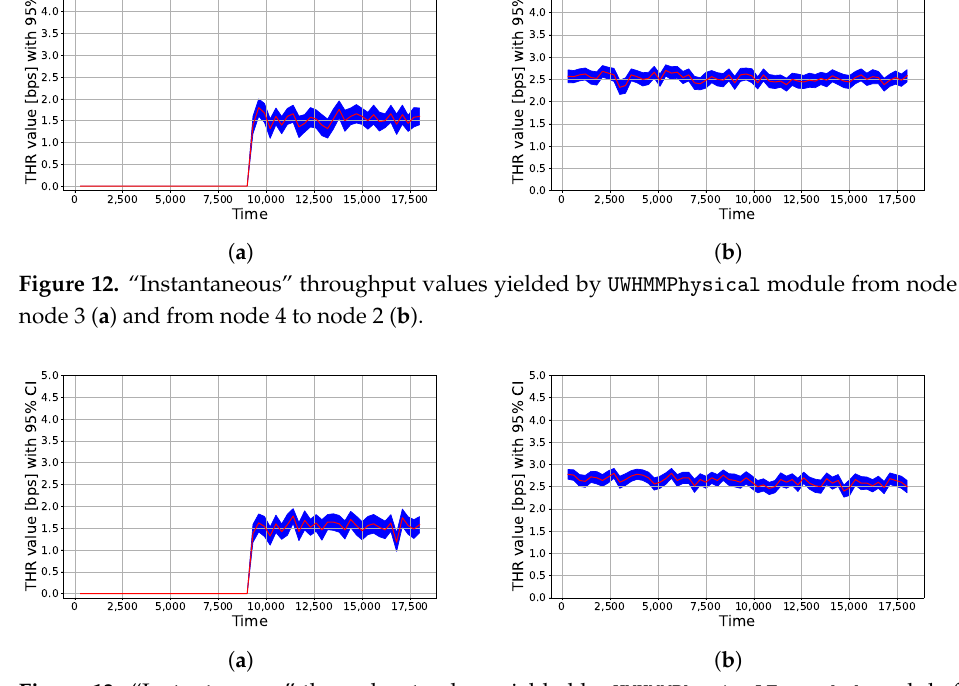
Figure 13. “Instantaneous” throughput values yielded by UWHMMPhysicalExtended module from node 1 to node 3 ( a ) and from node 4 to node 2 ( b